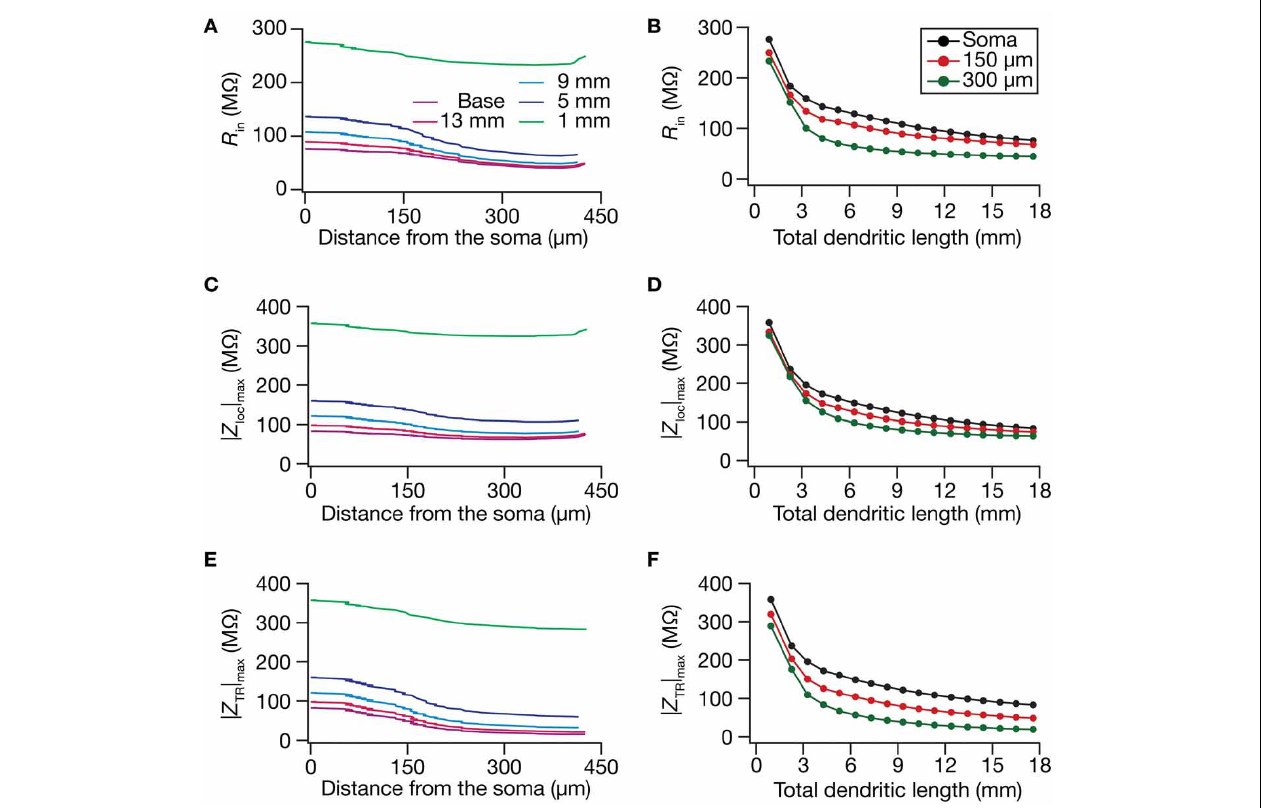
FIGURE 4 | In the presence of a somatodendritic HCN-channel gradient, steady-state and frequency-dependent measures of excitability increased with dendritic atrophy across somatodendritic locations. (A,B) Input resistance ( R in ) plotted as functions of somatodendritic location ( A ; for 5 different pruned morphologies, Figure 1A ) and total dendritic length ( B ; for 3 distinct somatodendritic